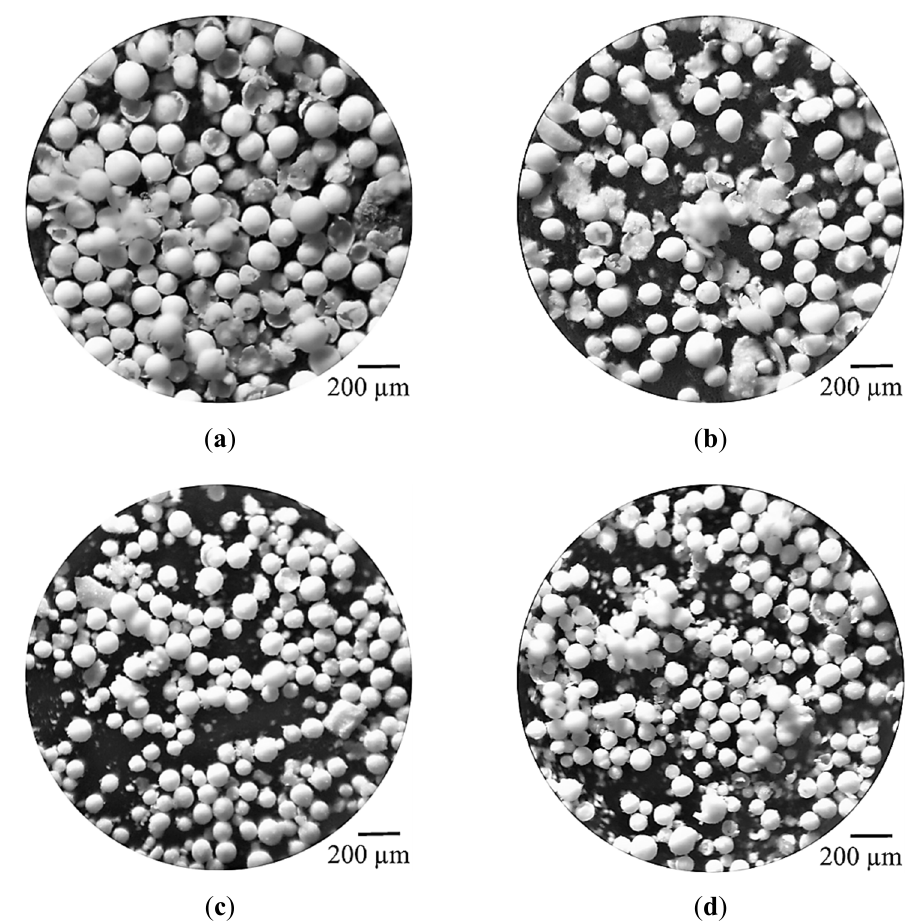
Figure A4. Optical microscopy of the spray-dried 25SA microspheres and calcined at 550 °C was obtained with the curved rectangular vanes disk: ( a ) P1 ‒ DAC; ( b ) P2 ‒ DAC; ( c ) P3 ‒ DAC; ( d ) P4 ‒